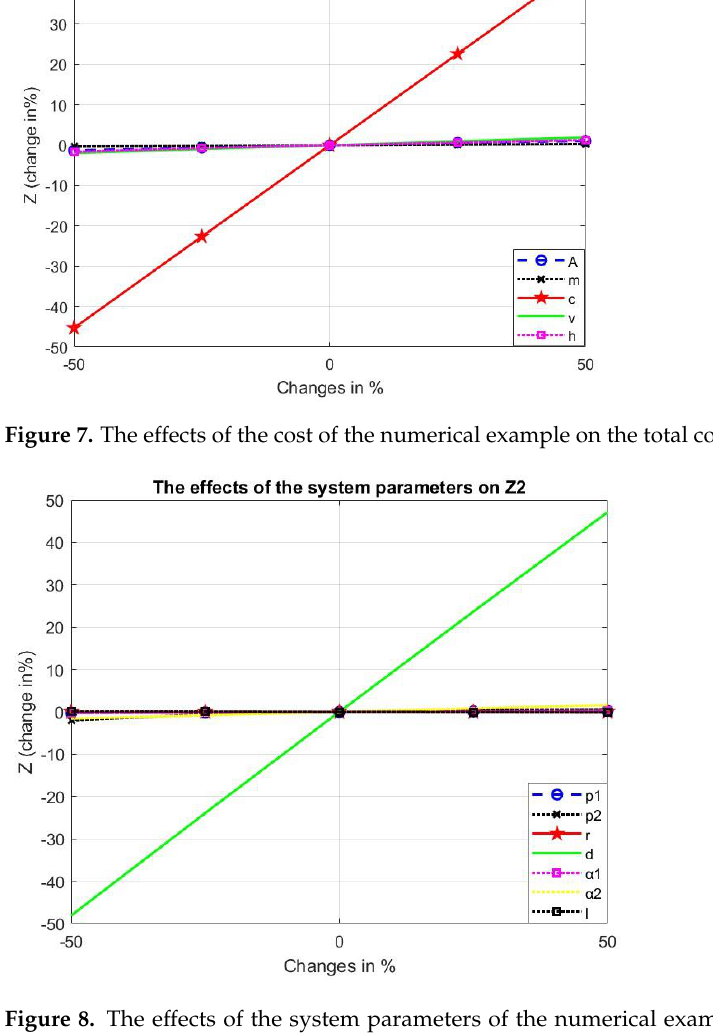
Figure 8. The effects of the system parameters of the numerical example on the total cost of the second model.